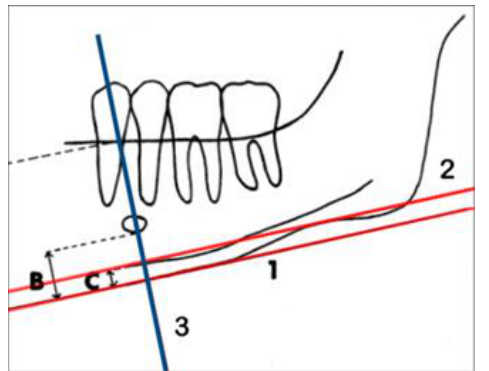
Fig1: Diagram show method of determination of cortical thickness in mental